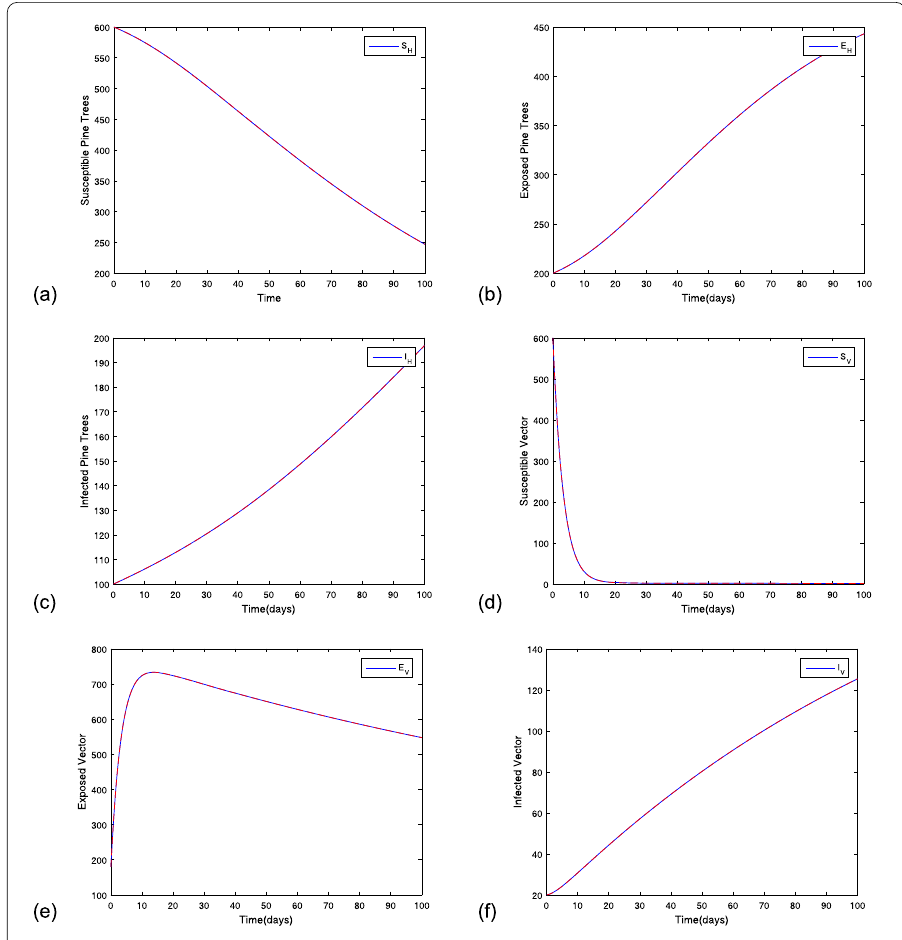
Figure 1 Simulations of pine tree population ( a )–( c ) and vector population ( d )–( f ) of the FPWD model (9) for τ = 1. ( a ): Susceptible pine tree; ( b ): Exposed pine tree; ( c ): Infected pine tree; ( d ): Susceptible vector; ( e ): Exposed vector; ( f ): Infected